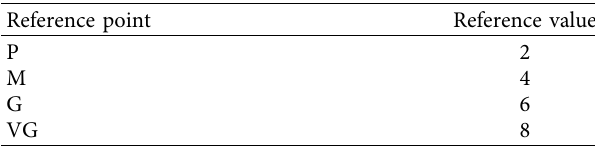
Table 3: Reference points and reference values for y .